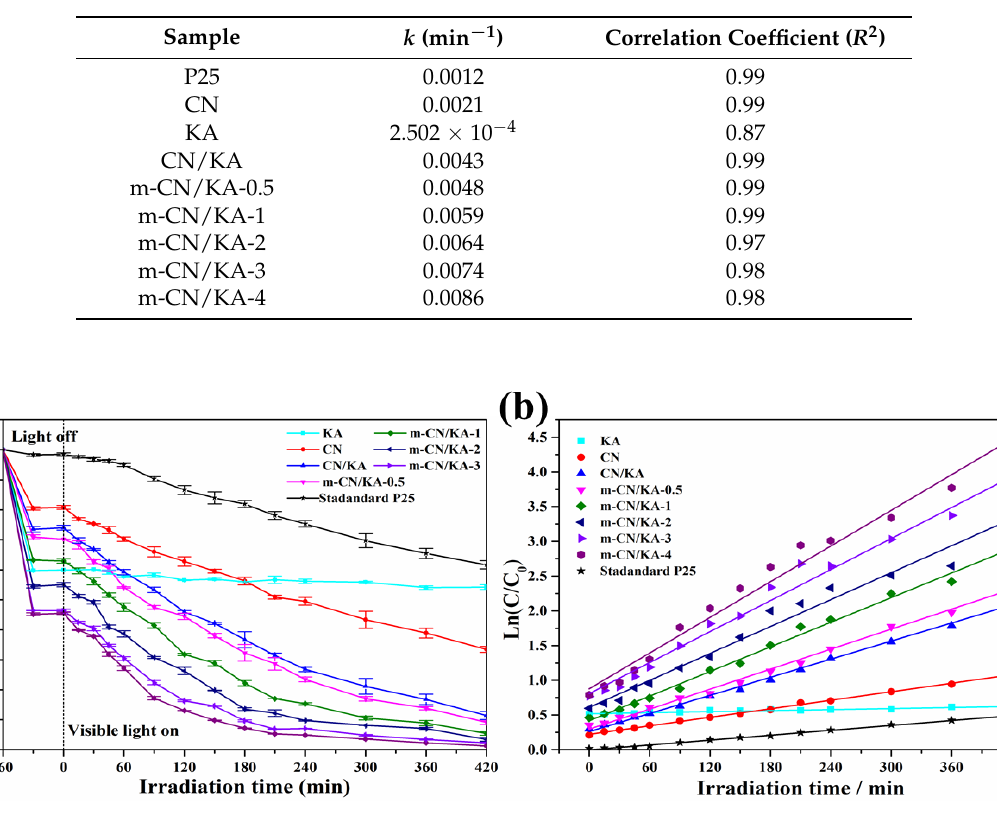
Figure 8. ( a ) Photodegradation of RhB by P25, CN, KA, CN/KA composite, and m-CN/KA composites with the average values ± the standard deviation of three replicates under visible light and ( b ) the corresponding first-order kinetics plots.